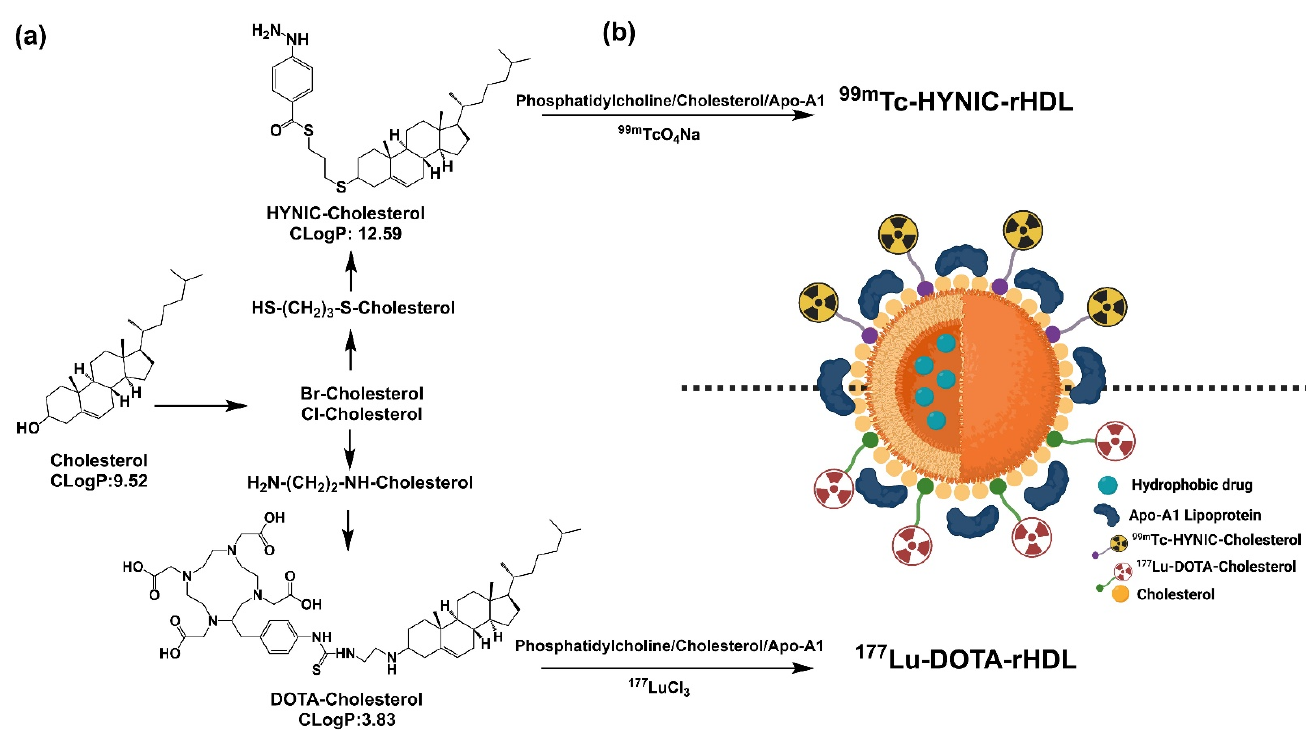
Figure 1. Schematic methodology for the preparation of a suitable platform for theranostic applica- tions. ( a ) Synthesis of cholesterol derivatives; ( b ) HYNIC-rHDL or DOTA-rHDL nanoparticles radi- olabeled with 99m Tc and 177 Lu. Table 1. Physicochemical properties of cholesterol derivatives.